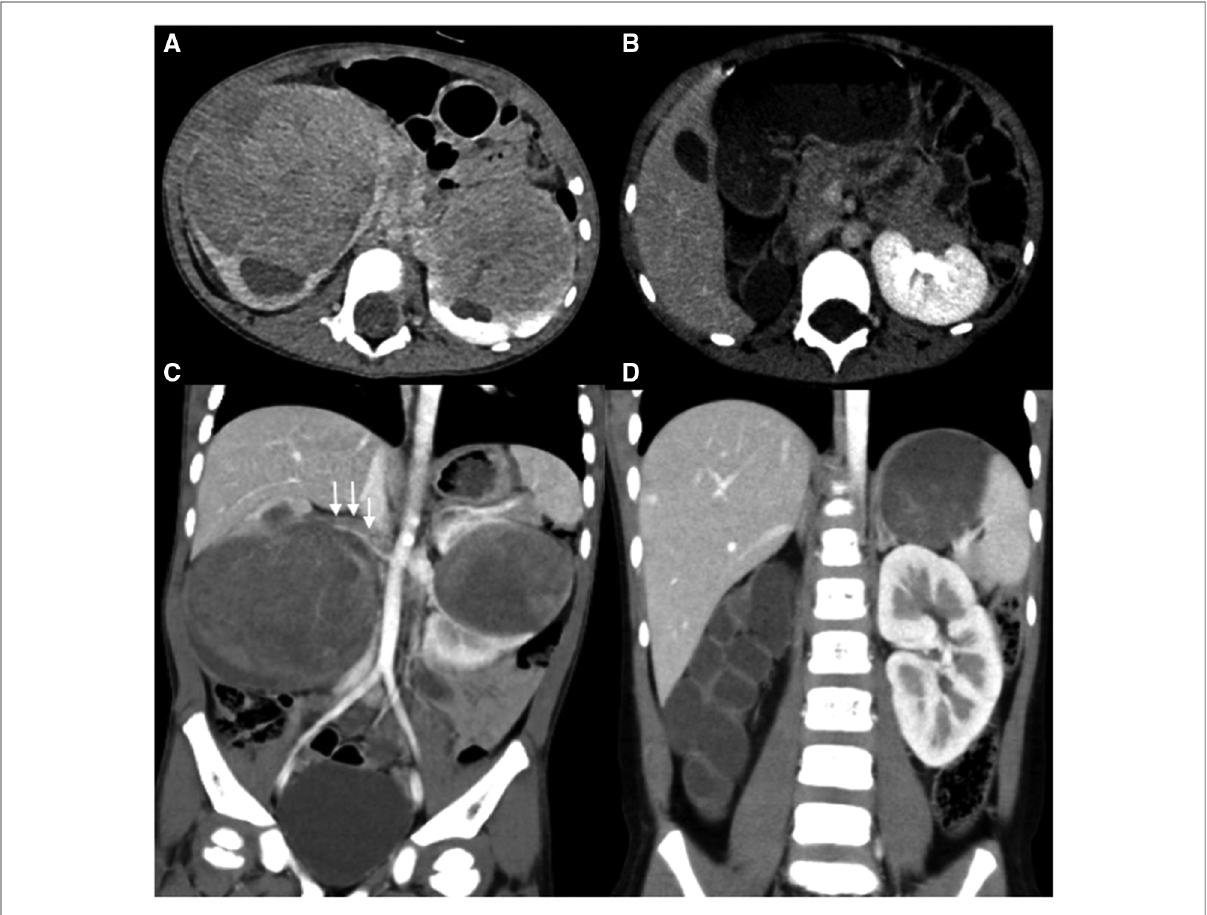
FIGURE 2 Abdominal CT scans of case 8. ( A,C ) Preoperative CT images reveal bilateral kidney lesions invading the renal sinus with bilateral hydronephrosis, a fi lling defect is noted within the right renal vein and inferior vena cava (white arrow). ( B,D ) Postoperative CT images reveal the absence of right kidney and Normal left